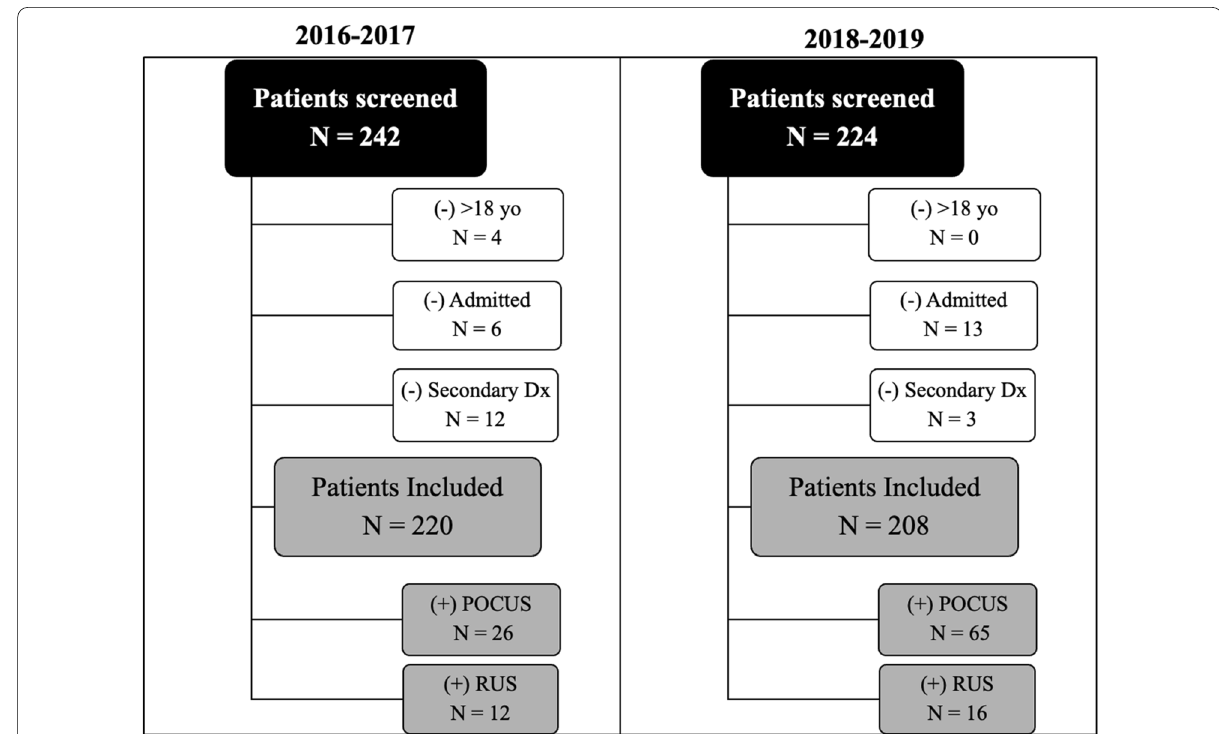
Fig. 1 Patient participant flowchart with inclusion and exclusion applied to patient selection pre- and post-intervention of SSTI